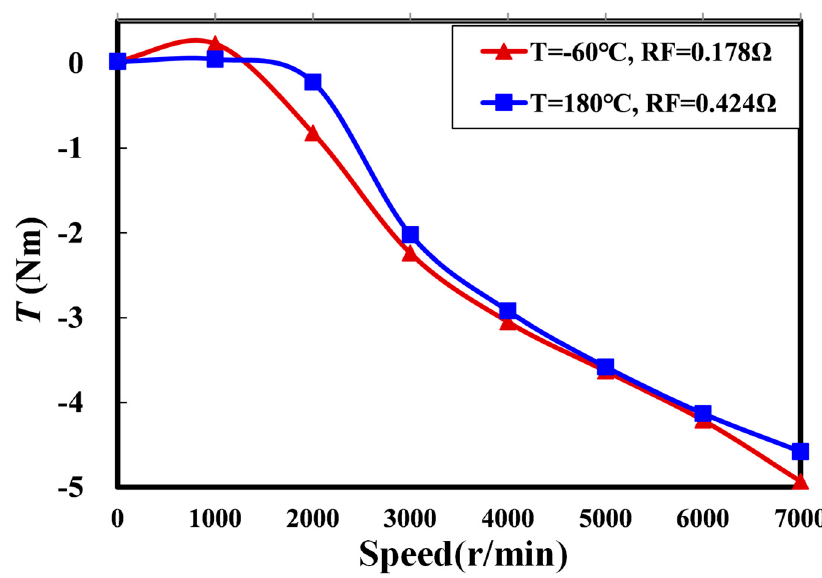
Figure 12. The curve of the torque of the exciter changing with the speed.